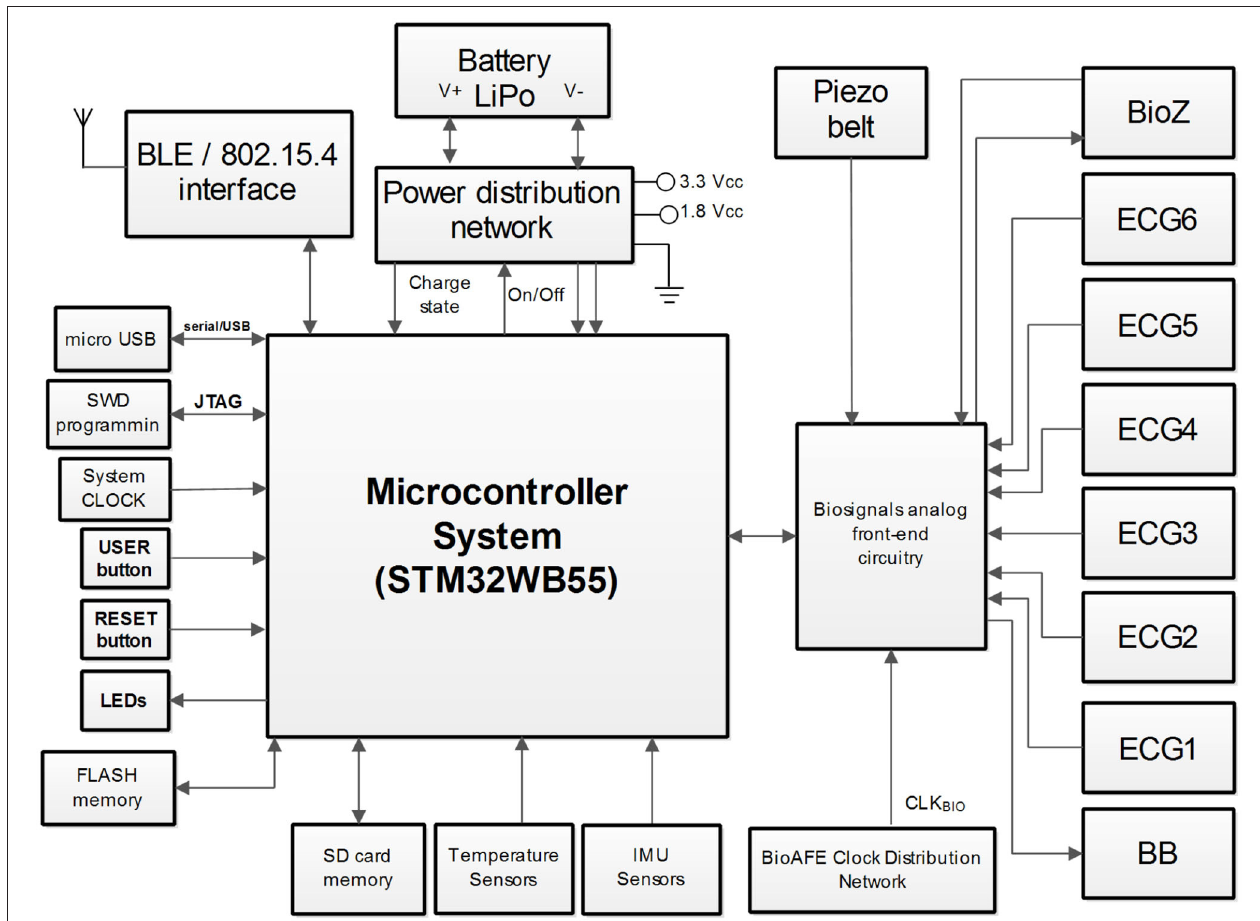
FIGURE 4 | The architecture of ATTICUS data acquisition